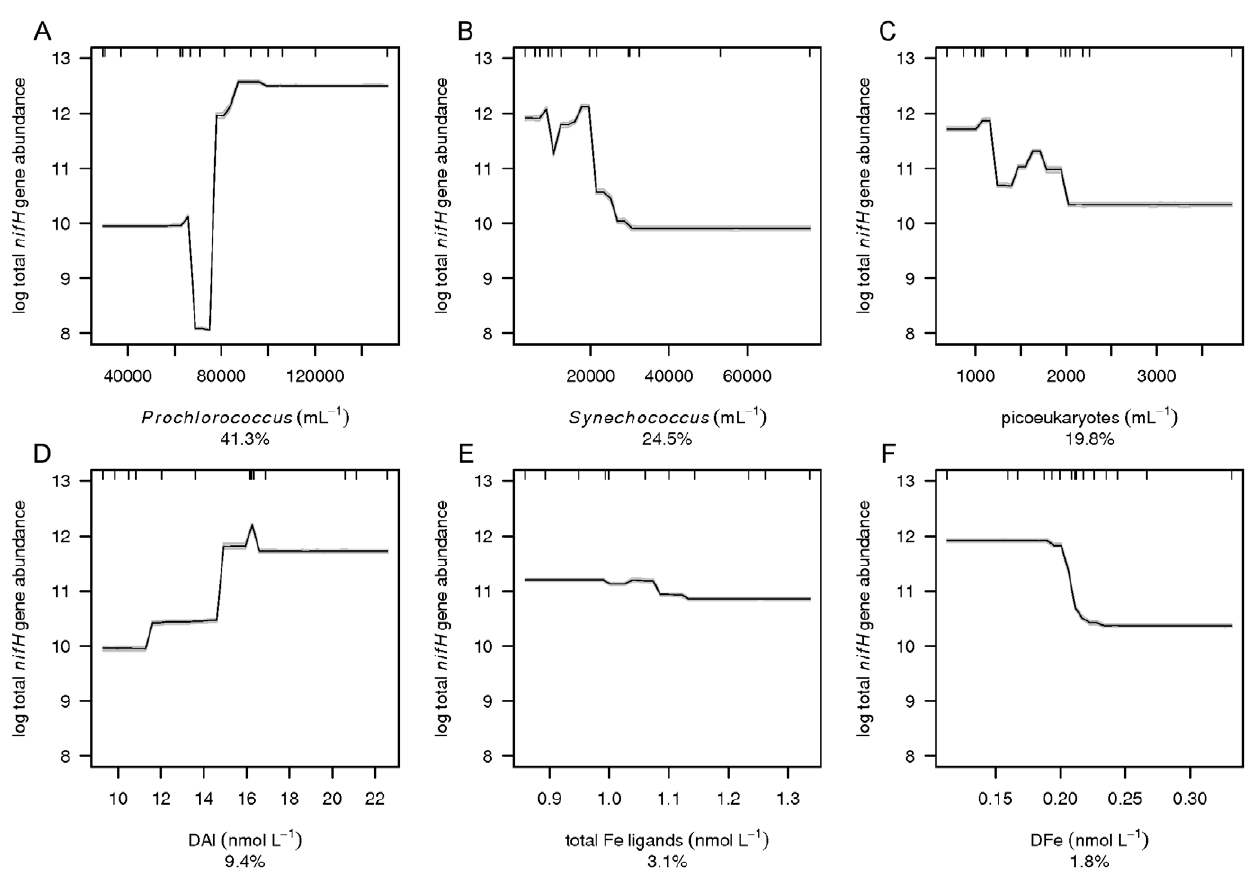
Figure 5. Mean partial dependence plots for the environmental variables describing the total nifH gene abundance. The partial dependence plots with 95% confidence intervals (light grey, based on bootstrapping of 30 BRT runs and indicating robustness of model performance) for the 6 environmental variables best at explaining the variation in total nifH gene abundance (the sum of Group A, gamma A and filamentous nifH genes). The 6 environmental variables are A) Prochlorococcus , B) Synechococcus , C) picoeukaryotes, D) DAl, E) total Fe ligands and F) DFe. The y-axis is centered to have zero mean over the log distribution of the fitted total nifH gene abundance. A common scale is used for the x-axis. Rug plots at inside top of plots show the distribution of sites across that variable, in deciles.